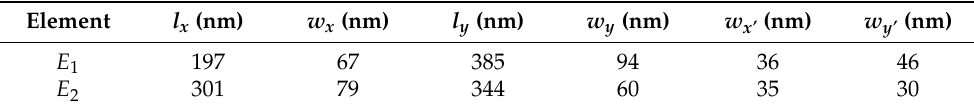
Figure 1. ( a ) Schematic of the periodic cross-shaped structure. ( b ) Schematic of a single cell. The parameters of each variable of the metasurface are labeled. ( c ) Schematic of the proposed phase- gradient metasurface. The two elements are marked as E 1 and E 2 . The detailed parameters are shown in Table 1. Table 1. Crucial Parameters of the Huygens’ Metasurface.